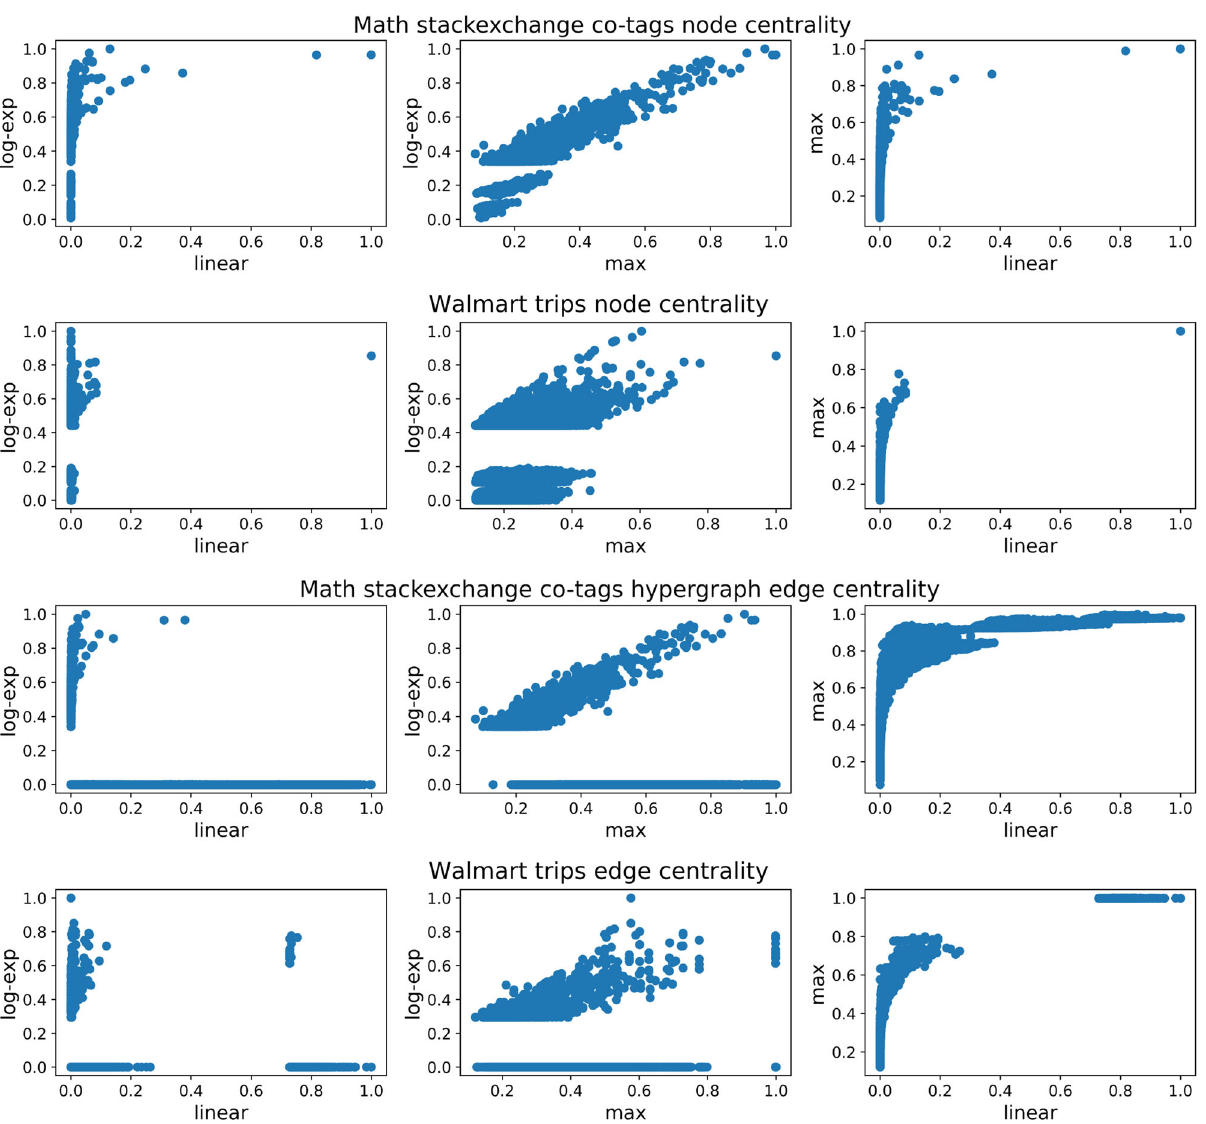
Fig. 2 Scatter plots of node and edge centralities. Scatter plots comparing node and edge centrality scores obtained with the "linear'', "log-exp'', and "max'' centrality models on the Math stackexchange co-tags and the Walmart trips hypergraphs. Each dot in the panels represents either a node or a hyperedge, with coordinates ( x , y ) corresponding to the centrality value assigned to that node or hyperedge by two different models, as speci fi ed by the panel — as well as the Kendall- τ and the Spearman correlation coef fi cients — middle and right panels, respectively — between the top k nodes ranked by the linear model vs the ranking assigned to the same nodes by the other models, for k which varies between 1 and 100. The intersection similarity 32 is a measure used to compare the top k entries of two ranked lists ℓ 1 and ℓ 2 that may not contain be the list of the the same elements. It is de fi ned as follows: let ‘ j k top k elements in ℓ j , for j = 1, 2. Then, the top k intersection similarity between ℓ 1 and ℓ 2 is